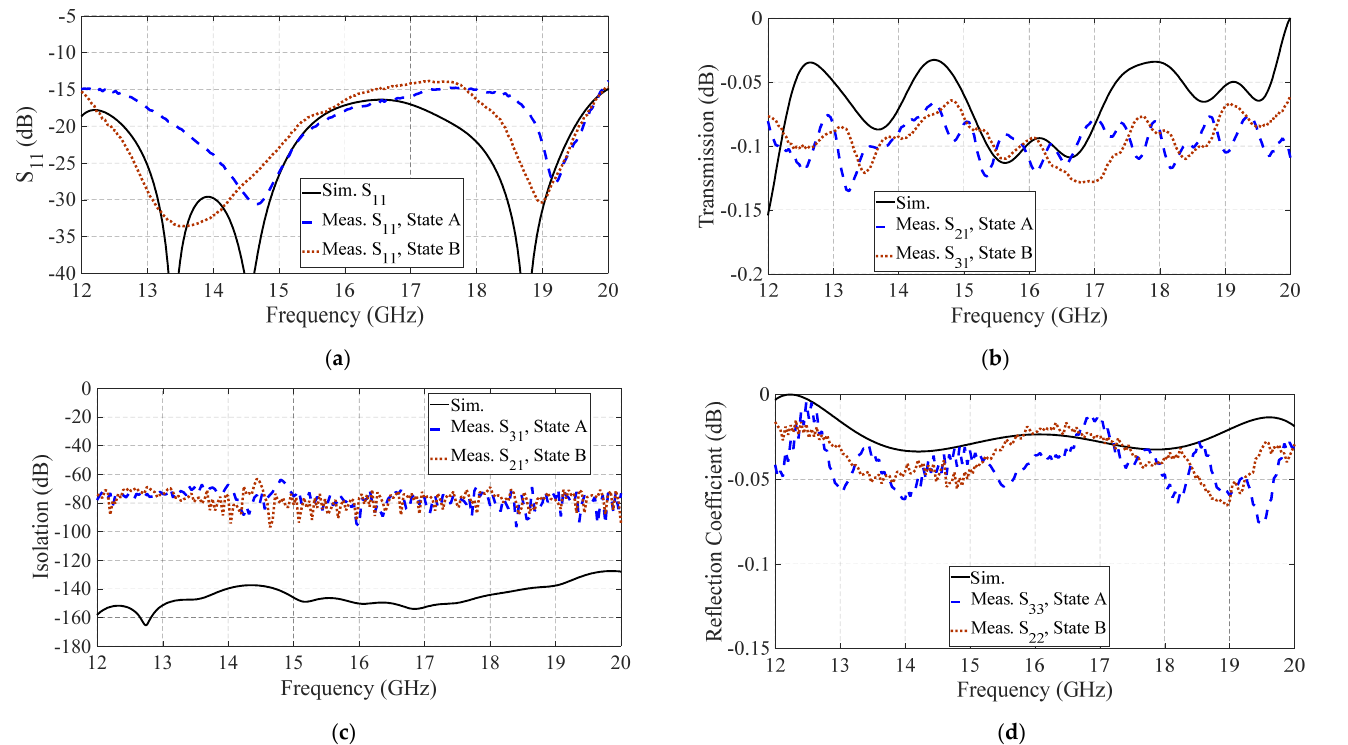
Figure 9. The simulated and measured ( a ) reflection coefficient (S 11 ) of the pole-port, ( b ) transmission coefficient, ( c ) isolation level, and ( d ) reflection coefficient of the shorted port, for both states A and B.